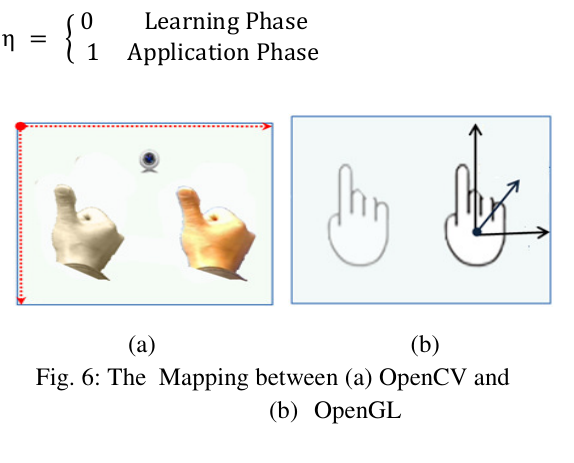
Fig. 6: The Mapping between (a) OpenCV and (b) OpenGL